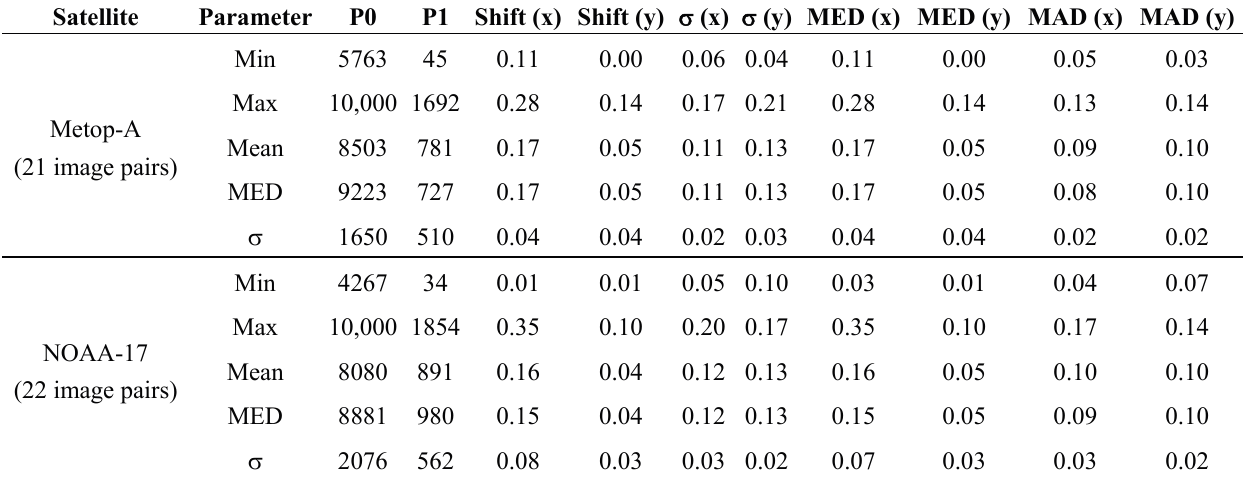
Table 7. BBR accuracy evaluation results between AVHRR Bands 2 and 3A; statistical summary from the point matching results of all images for the two satellites. The given statistics are in pixels and are derived from the absolute values.